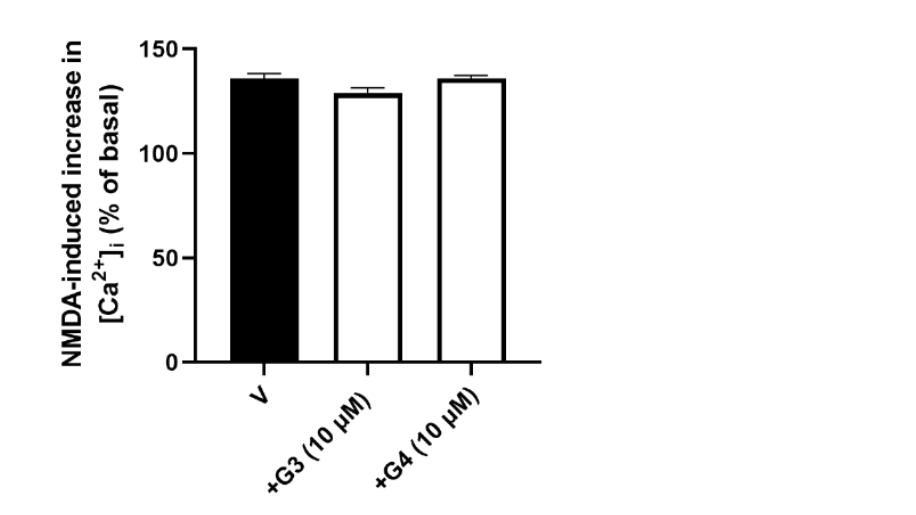
Figure 2. Effect of phosphorous dendrimers on NMDA-induced increase in [Ca 2+ ] i . Neurons were treated (10 µ M; 1 h) with G3 or G4 phosphorous dendrimers. Then, the neurons were incubated with Fura-2 and exposed to NMDA (150 µ M) in the absence (V) and presence of dendrimers. Data represent the percentage over basal line (100%) of the ratio of fluorescence taken as an index of [Ca 2+ ] i , as indicated in the Materials and Methods section. The data are expressed as the mean + the s.e.m. of 30 to 40 neurons obtained from three independent experiments.